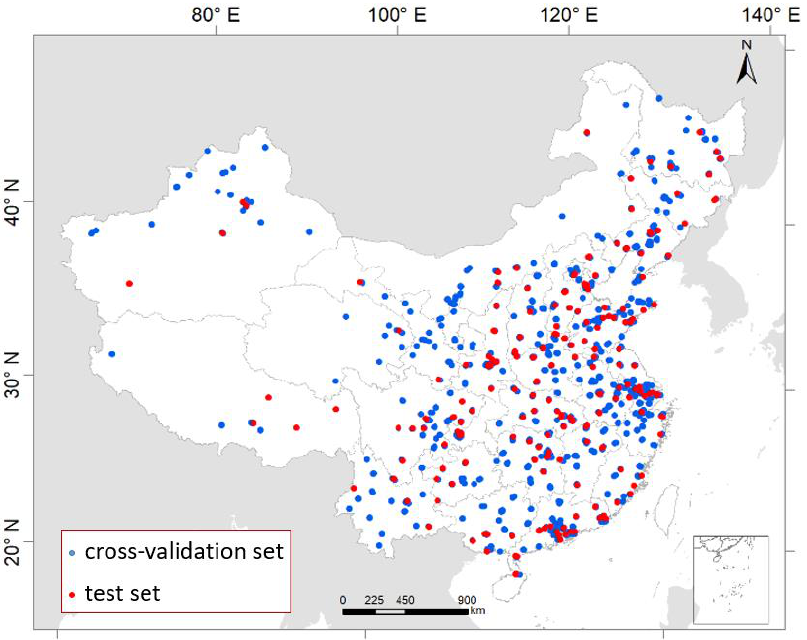
Figure 1. Study area.